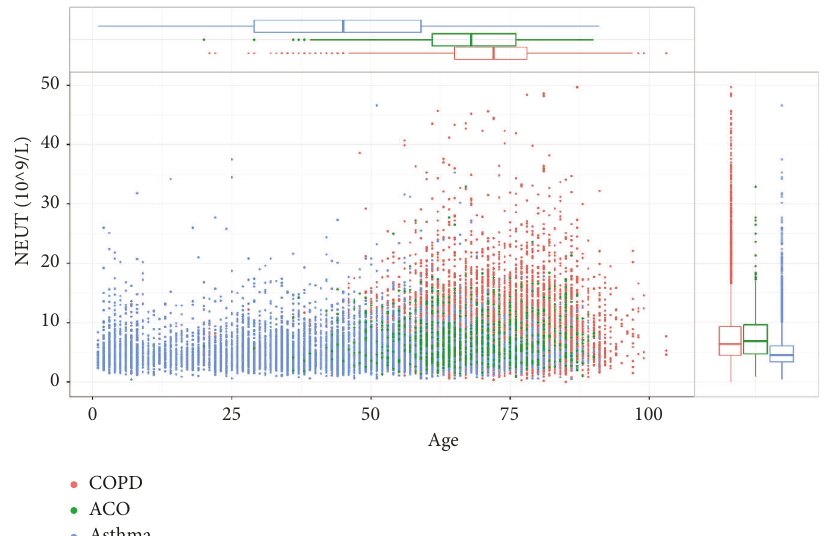
Figure 2: Distribution of neutrophils at different ages in the three diseases. (COPD, chronic obstructive pulmonary disease; ACO, asthma- COPD overlap; NEUT, neutrophils).